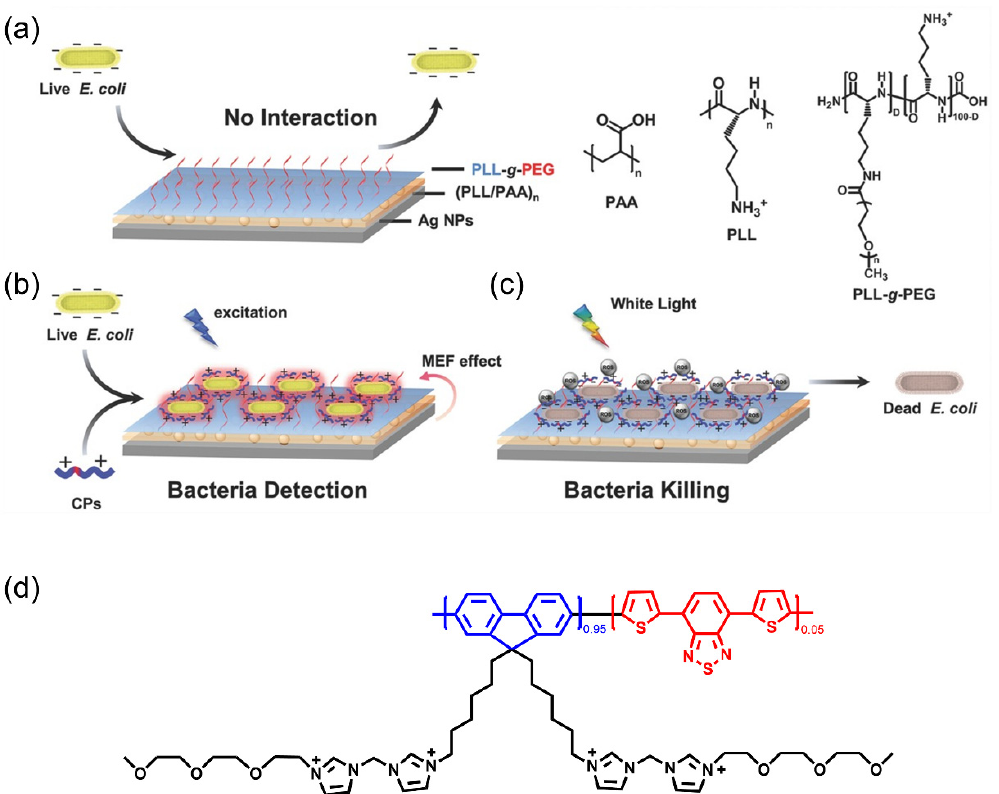
Figure 15. Illustration of multifunctional platform based on conjugated polymer–silver nanostructure for detecting and killing bacteria. ( a ) The anti-adsorption surface based on silver nanostructure. ( b ) Bacteria detection and killing surface modified with conjugated polymer. ( c ) CPs produced ROS under white light irradiation for disinfection. ( d ) Chemical structures of cationic PFDBT-BIMEG. Reproduced from Ref. [59] with permission from the Royal Society of